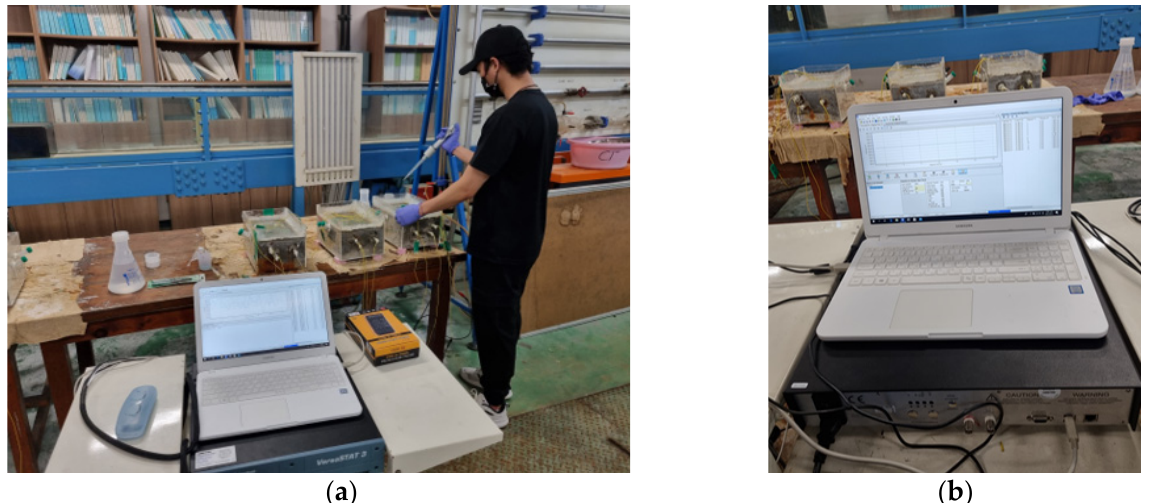
Figure 6. Open-circuit potential (OCP) monitoring stage and equipment. ( a ) OCP monitoring during accelerating conditions; ( b ) OCP measurement equipment.